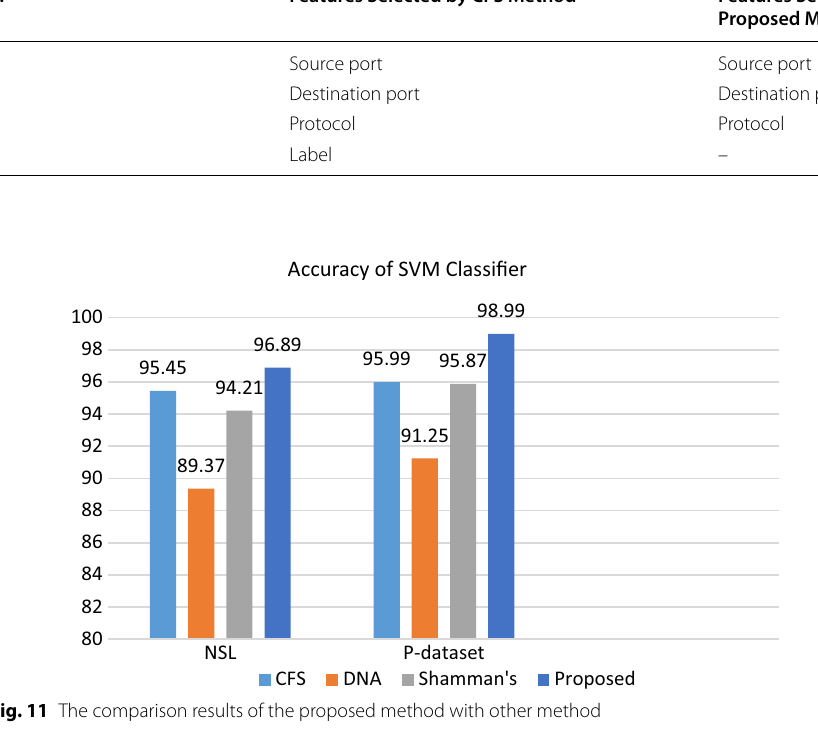
Table 25 Selected features by CFS method and proposed method on CICIDS-dataset No.